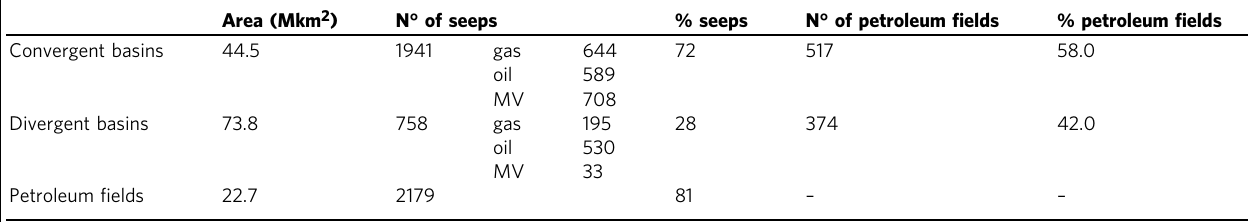
Number (and percentage) of seeps within convergent and divergent basins and petroleum fi elds, and number (and percentage) of petroleum fi elds within the two groups of basins. MV mud